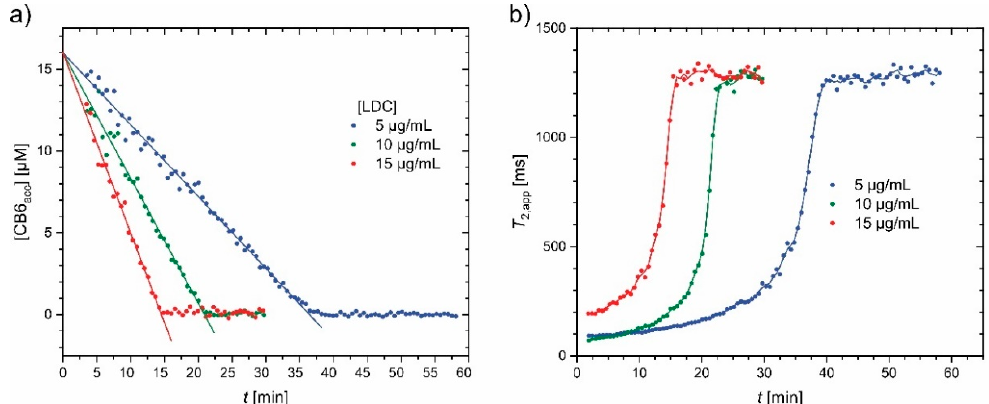
Figure 9. Monitoring LDC enzyme activity with HyperCEST. ( a ) The amount of Xe-accessible CB[6] decreases as the enzyme converts lysine into cadaverine. The CEST effect, which is finally lost, allows to directly derive [CB6 acc ] when the starting concentration is known. ( b ) Likewise, the decreasing amount of Xe that can engage in fast reversible binding causes a loss of exchange-induced T 2 effects. T 2 increases until only free Xe in solution exists. The kink in the curve yields the time when 16 µM of CB[6] are completely blocked by cadaverine. Reproduced with permission from [162], Copyright ©